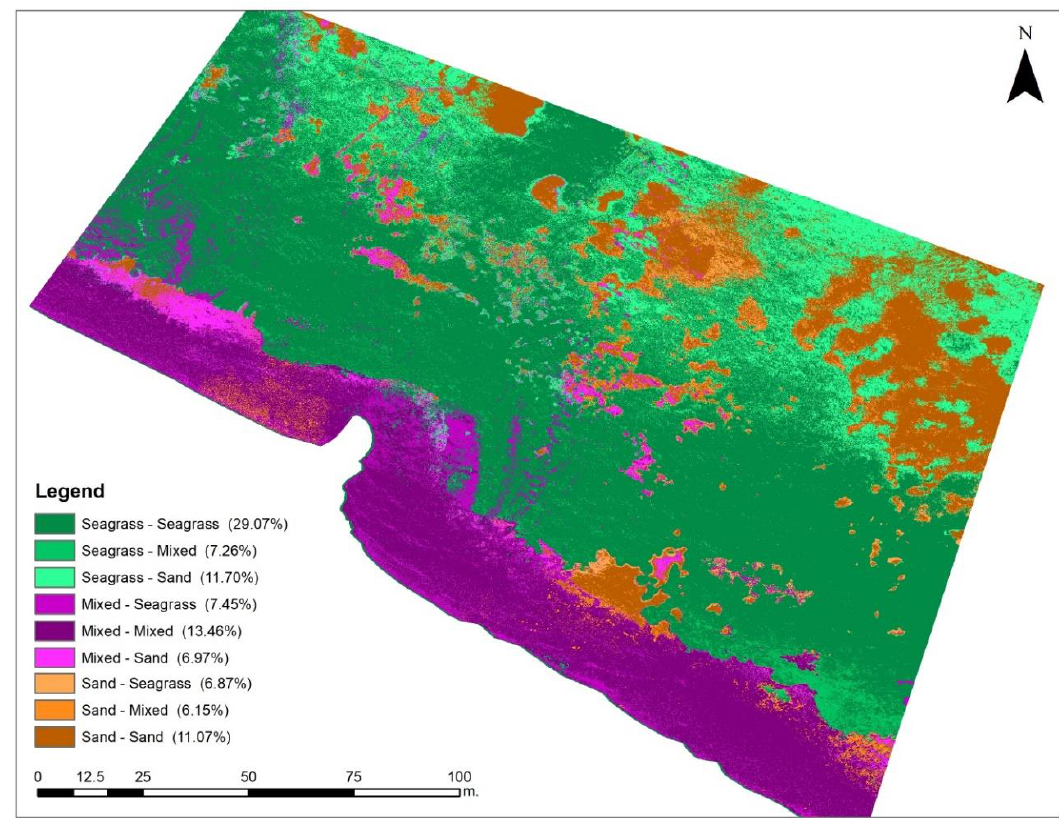
Figure 8. Map of change detection result between optimal and non-optimal survey maps. In deeper colors are presented the areas of the classes that have remained the same in both cases. Percentage changes of the classes are presented in the legend.